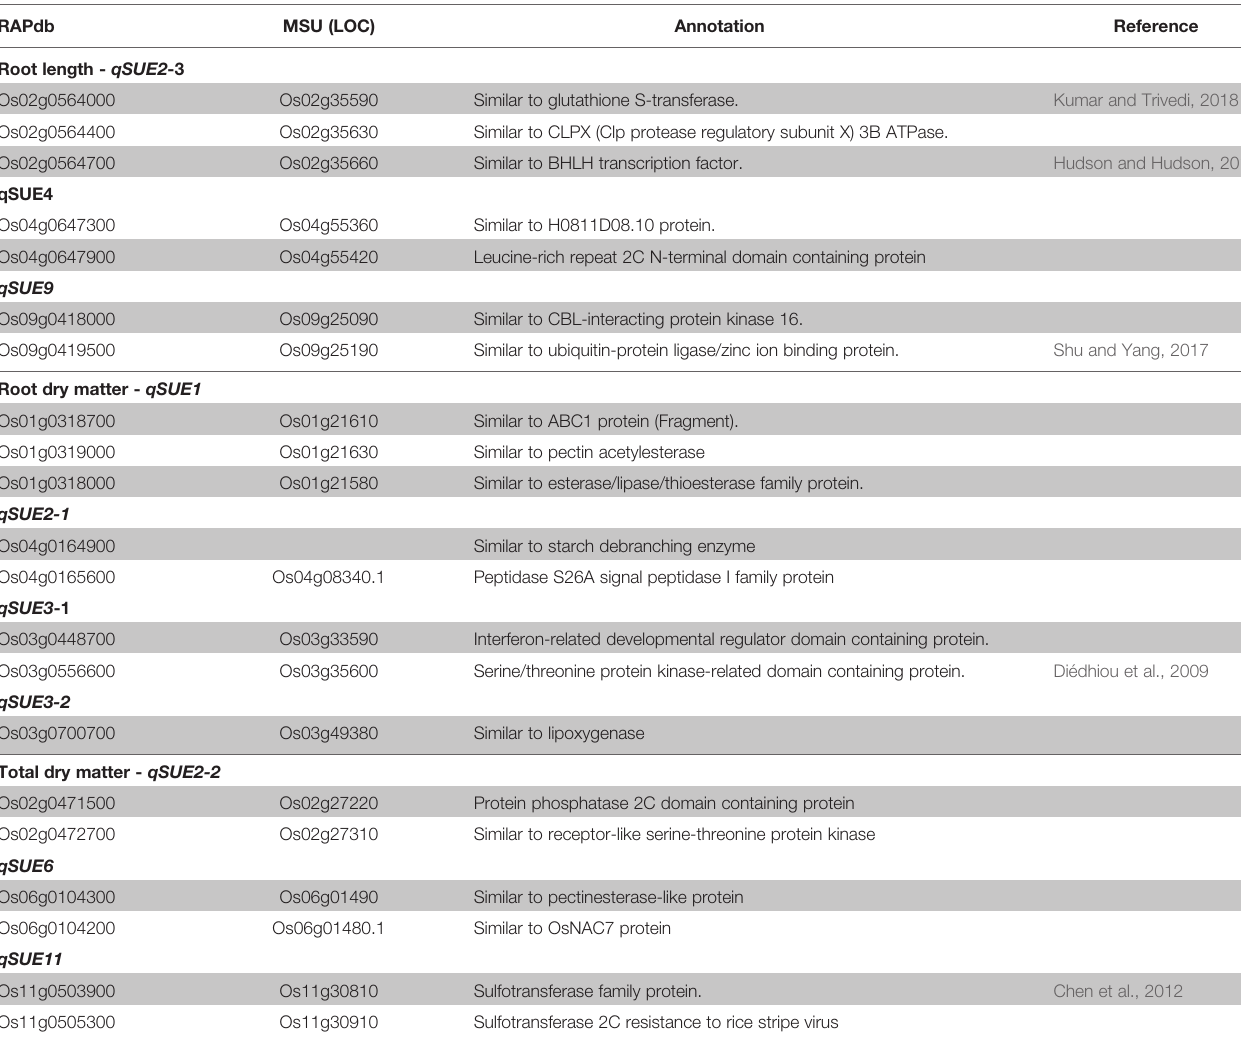
TABLE 4 | List of candidate genes in each